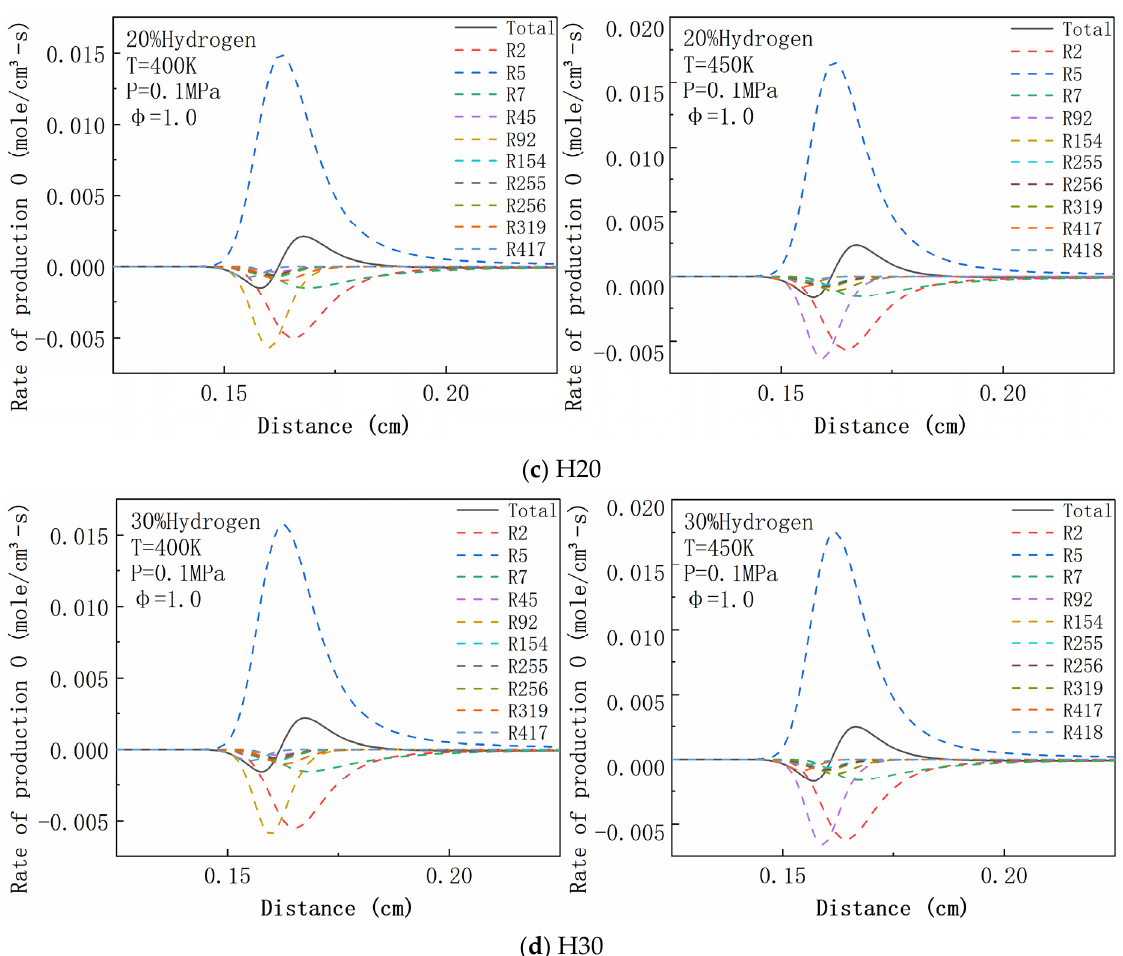
Figure 14. Rates of O radical production for various fuels. Working conditions at ϕ = 1.0 and P = 1 bar: ( a ) Ethanol, ( b ) H10, ( c ) H20, and ( d ) H30 left: 400 K and right: 450 K.